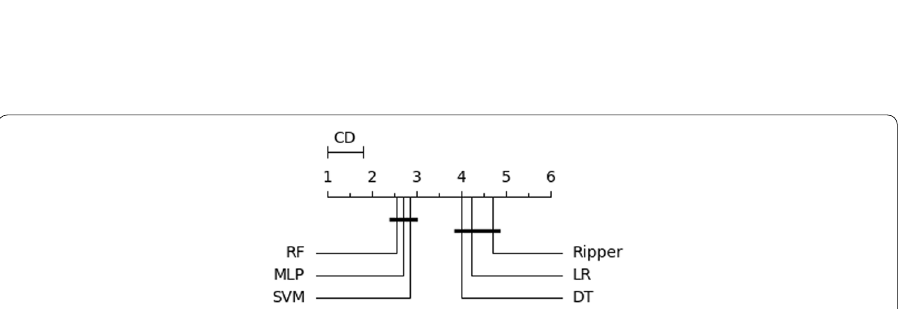
Fig. 6 Critical difference diagram of the comparison of classifiers. Models that are not connected by the bold line have a significant difference in performance (at a 5% level with the Nemenyi